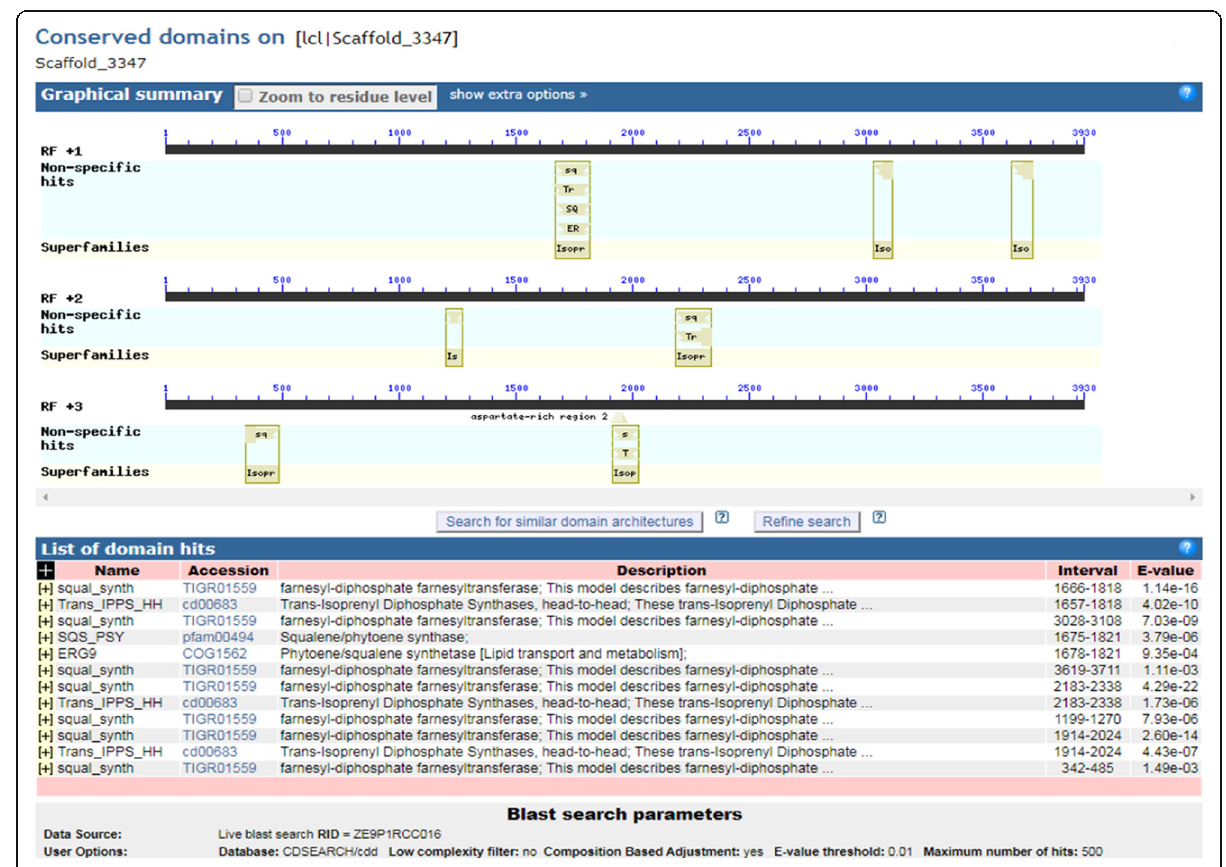
Fig. 6 Similarity of the scaffold representing SQS gene at the domain level using the CDD